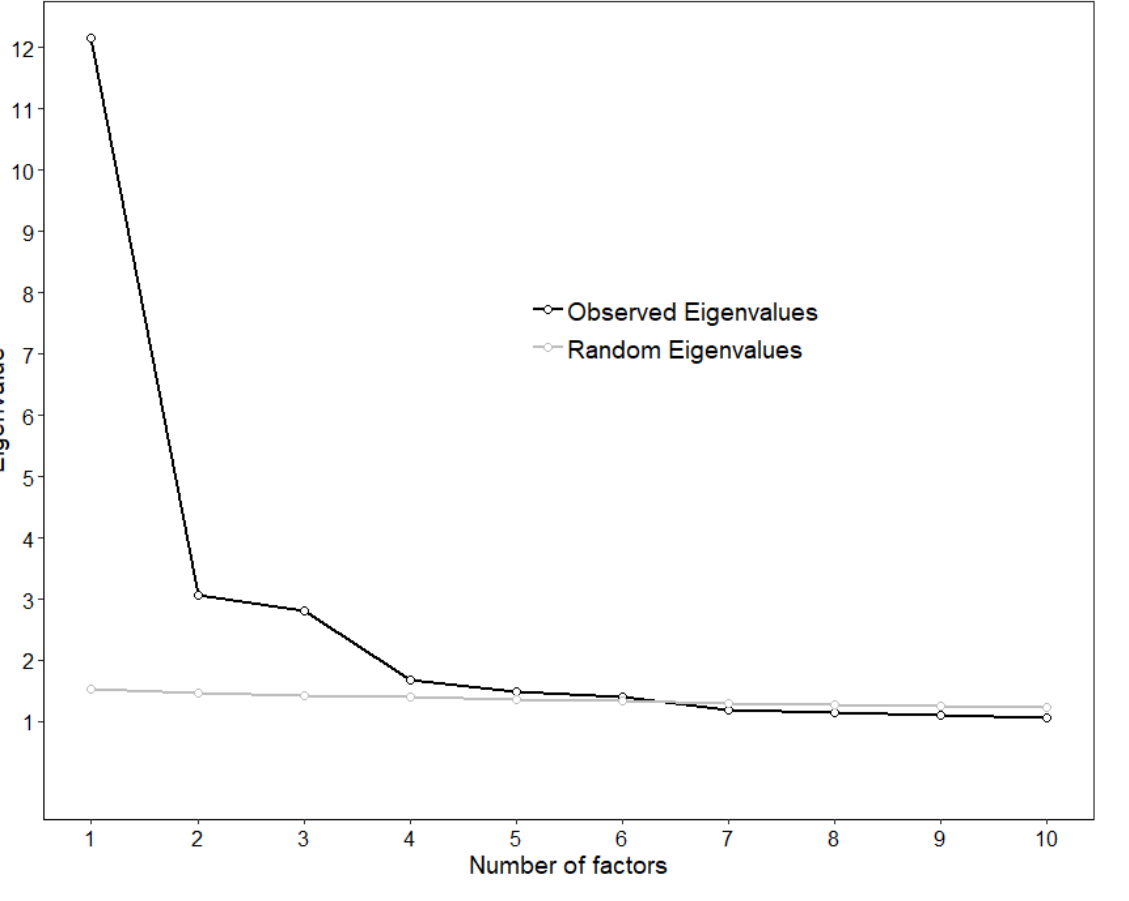
Figure 2. Results of the dimensionality analyses on the first random split of the total sample ( n = 668). Table 1. Loading matrix and factor correlations of the three-factor exploratory structural equation modeling solution.